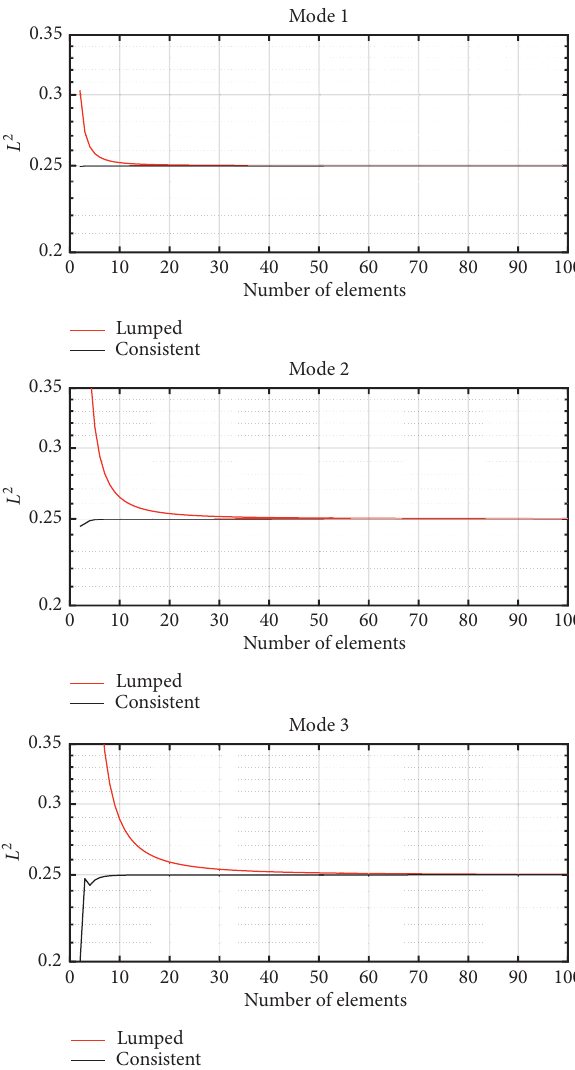
Figure 3: Convergence of the modal masses for the first three modes of the cantilever beam with constant mass density.